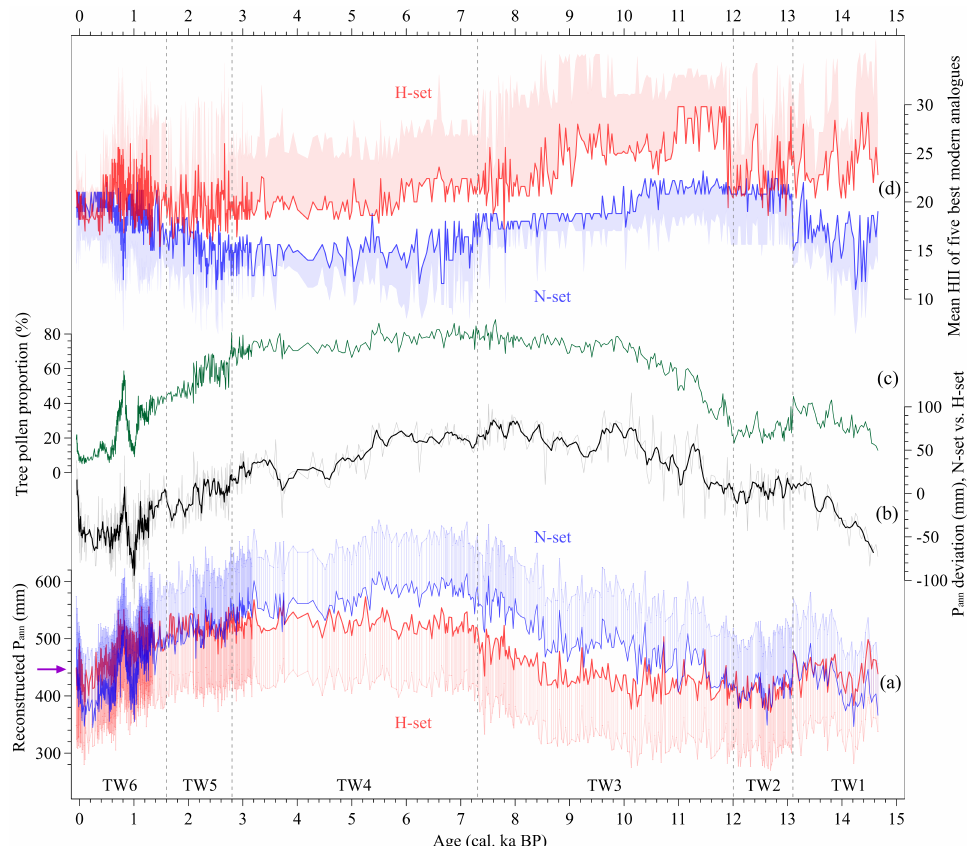
Figure 6. Fossil pollen record of Lake Gonghai: (a) reconstructed annual precipitation using a natural set (N-set; blue) with upper-side standard error of prediction (SEP) and a human-induced set (H-set; red) with lower-side SEP. The modern instrumental value is marked on the scale axis for comparison (purple arrow). (b) Deviations in the reconstructed precipitation (grey) between the N-set- and H-set-based transfer functions with a 5-point moving average smoother (black). (c) The proportion of tree pollen taxa (%) and (d) the mean HII value of the five best analogues in the N-set (blue, with lower-side standard deviation) and the H-set (red, with higher-side standard deviation) for fossil samples. Six time windows (TWs) delineated according to the deviation pattern between the two reconstructions are separated by grey dashed